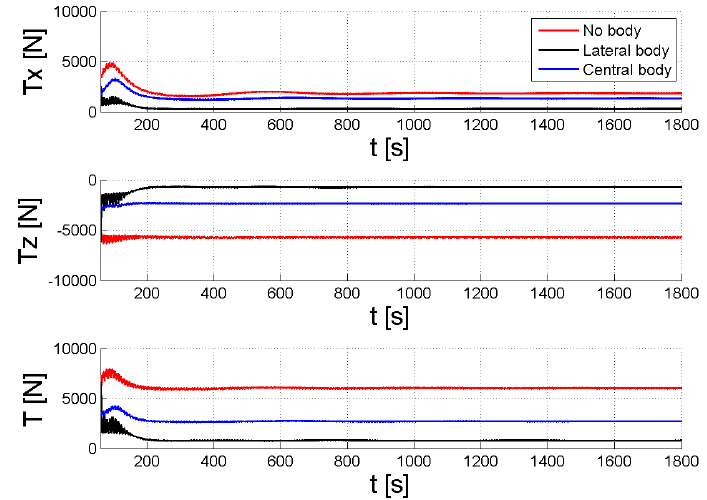
Figure 25. Floating towed bodies towed with cables with different intermediate body arrangements.